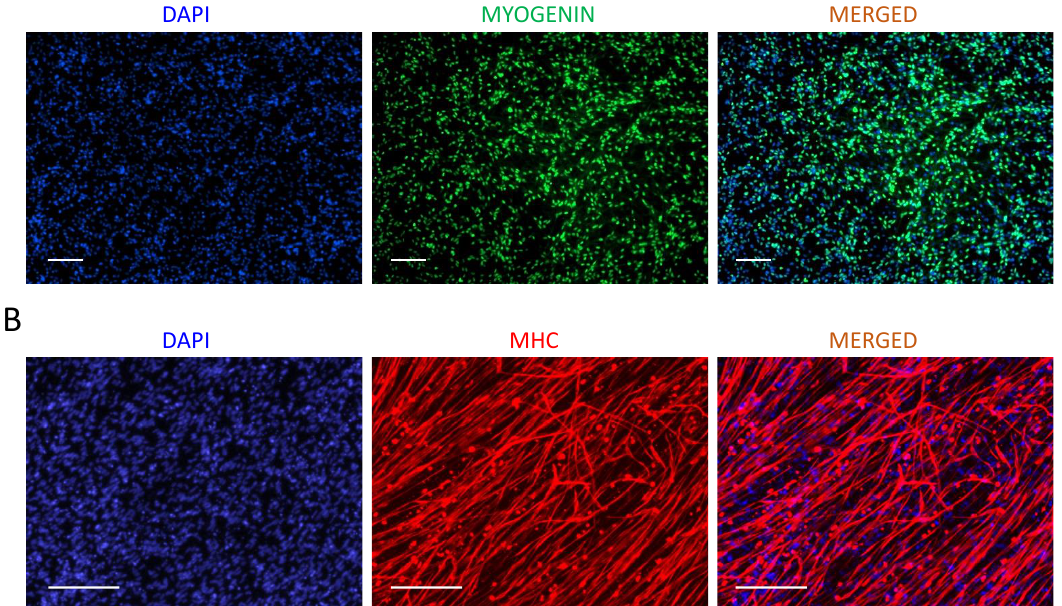
Figure 3. Myotube formation of hiPSC-derived sorted myogenic cells at terminal stage of differentiation. ( A ) Immunostain- ing for MYOGENIN (green) demonstrates uniform nuclear expression of the marker in terminally differentiated cells at the last time point. Scale bars: 100 µm. ( B ) Immunostaining for myosin heavy chain/MHC (red) demonstrates formation of elongated myotubes at the end of terminal stage. Scale bars: 100 µm.